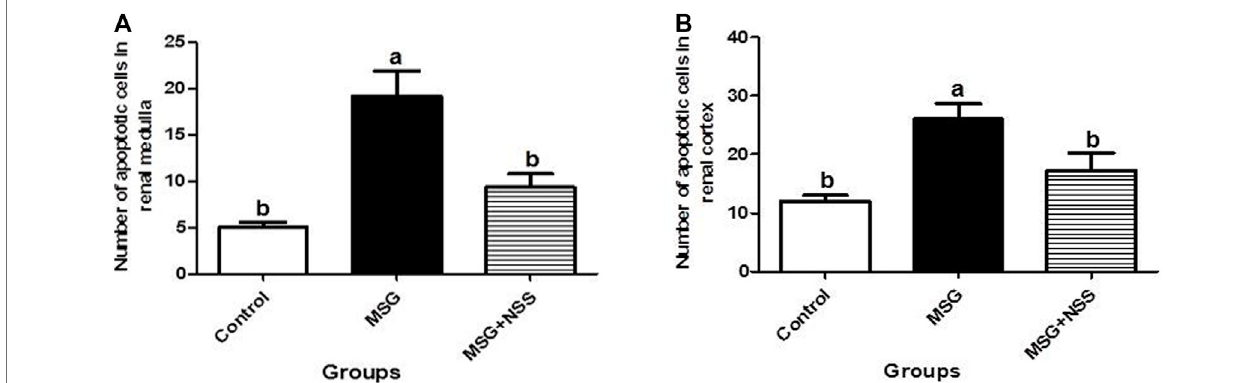
FIGURE5| Morphometricanalysisofthenumberofapoptoticcellsintherenalmedulla (A) andcortex (B) .Resultsareexpressedasthemean±SEM. a Signi fi cantly different from the control group and b signi fi cantly different from the MSG group and indicate signi fi cant differences at p < 0.05 (one-way ANOVA followed by Duncan ’ s